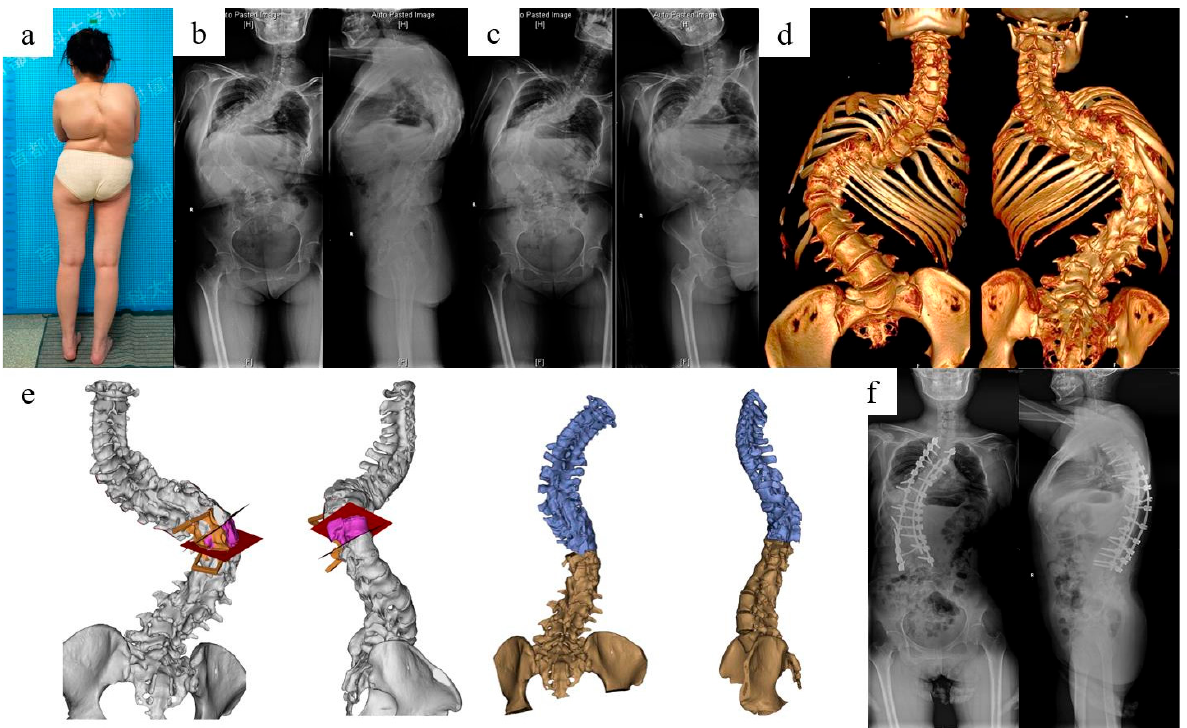
Figure 9. Radiological images and surgical plan simulation of case 2 with kyphoscoliosis deformity. A 33-year-old female patient had a previous history of spinal correction surgery 21 years ago, and was given T10 VCR osteotomy and T3-L4 fixation and fusion utilizing the personalized surgical simulation and 3DP guidance templates. ( a ) Outlook for case 2; ( b ) preoperative full-spine standing X-ray; ( c ) full-spine bending X-ray; ( d ) full-spine CT 3D construction; ( e ) simulation of VCR osteotomy; ( f ) postoperative full-spine standing X-ray showing great improvement for the deformity.